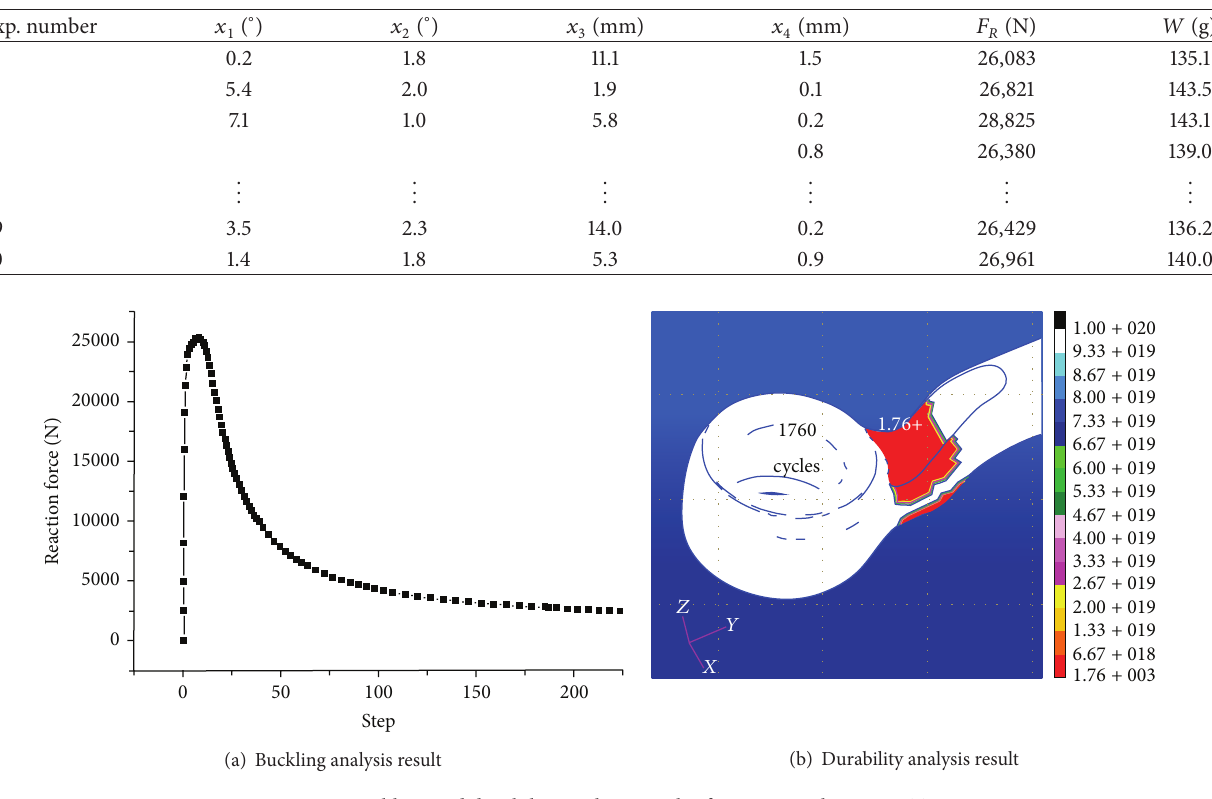
Table 2: Design of experiments using LHD.